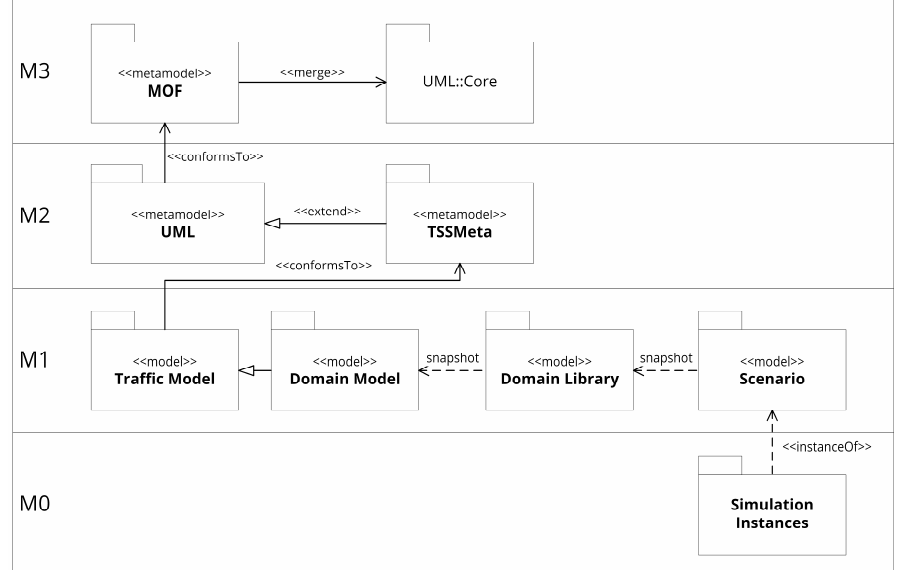
Figure 16. Package Diagram depicting the different models and their placement inside the four- layered MOF